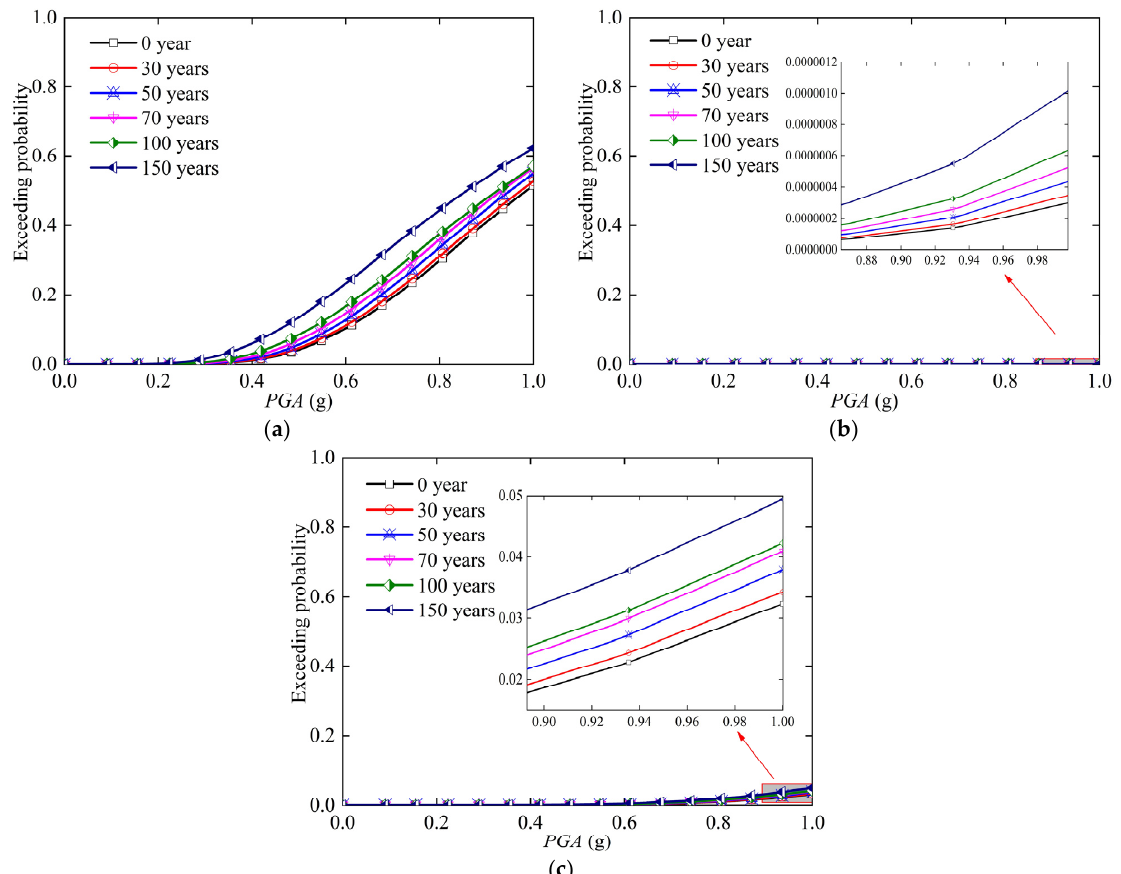
Figure 7. Time-variant fragility curve of piers in the state of complete damage: ( a ) 1 # Pier; ( b ) 2 # Pier; Figure 7 ( c ) 5 #